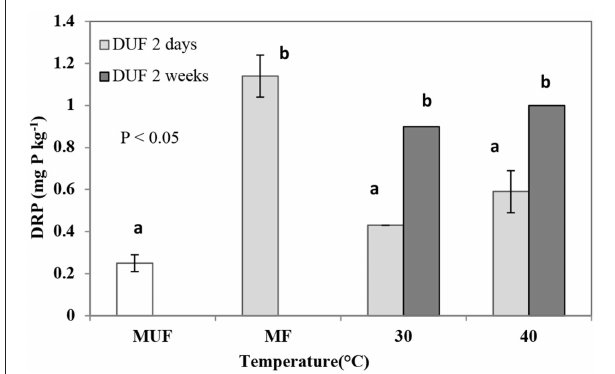
FIGURE 1 | DRP (mg P kg − 1 ) leached in 2 and 14-days dried unfumigated (DUF) treatments at 30 and 40 ◦ C. Error bars represent standard deviation (for some columns error bars are too small to be seen), n = 3. MUF, moist unfumigated soil and MF, moist fumigated soil. Means with the same letter are not significantly different from each other at the significance level of P < 0.05 as determined using Tukey’s post-hoc test.